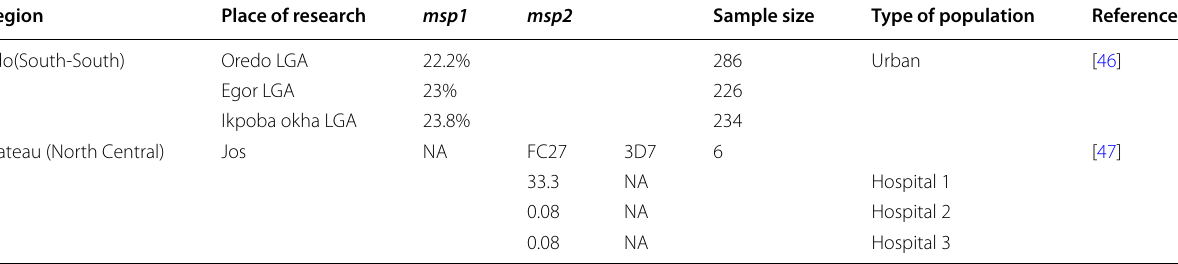
Table 2 Regions with incomplete/unclear information of genetic diversity of P. falciparum isolates in Nigeria